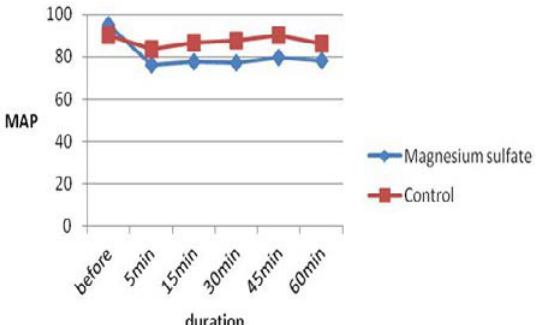
Figure 2. Depicts the mean arterial pressure (MAP) changes in the study groups Group Control Magnesium Sulfate